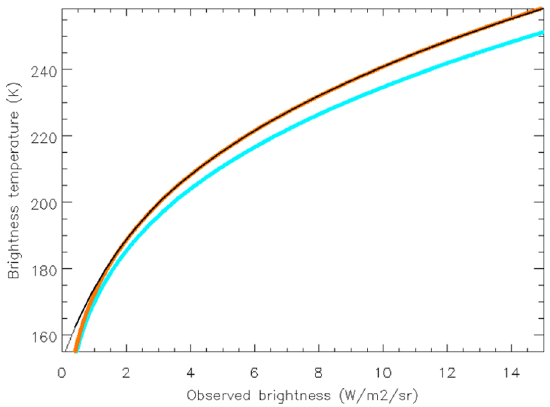
Fig. 7 Comparison of brightness temperatures derived with LIR’s response approximated by the boxcar function (light blue) and with that shown in Fig. 6 (red). A black solid line indicates approximation of the temperature profile with a 7‑degree polynomial function used in the data processing in this study